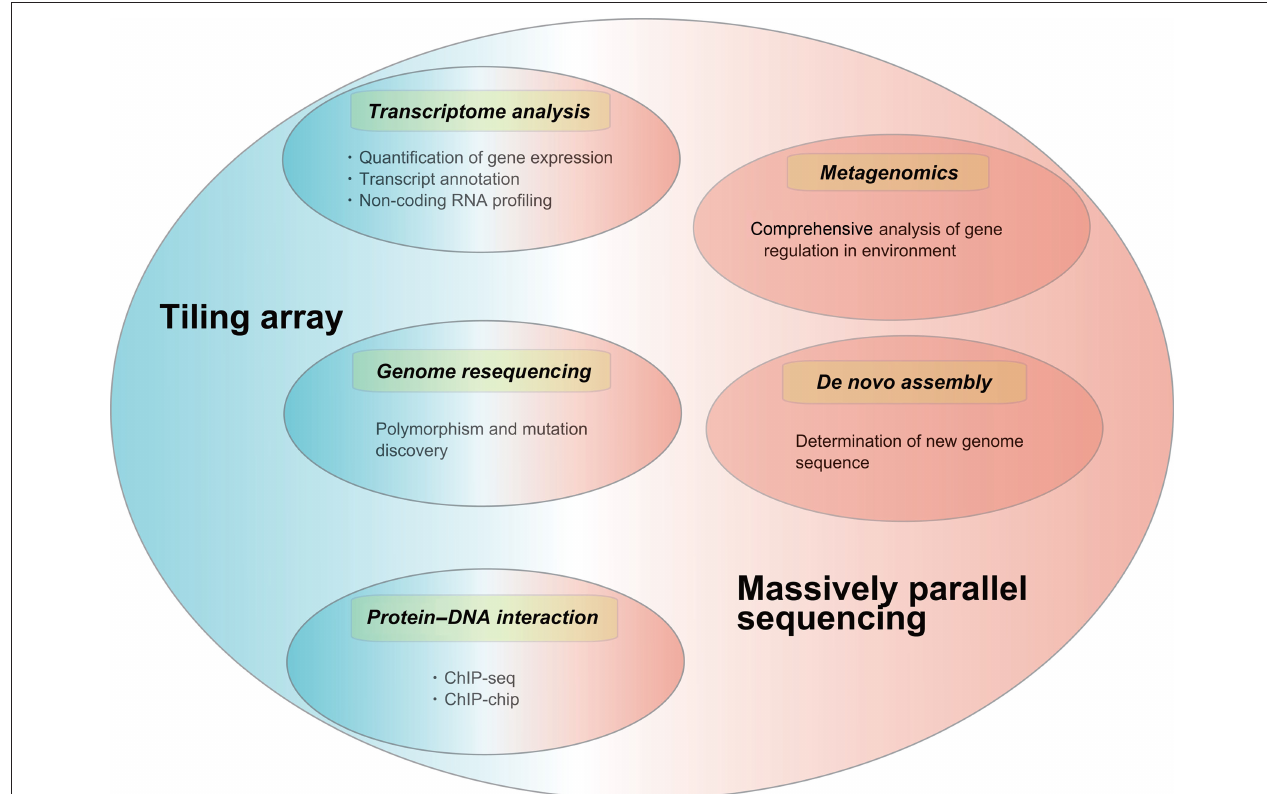
Figure 1 | Applications of tiling array and massively parallel sequencing. Transcriptome analysis, genome resequencing and protein–DNA interaction (ChIP-) studies can employ both tiling array and massively parallel sequencing while applications like metagenomic studies and de novo assembly can only be performed using massively parallel sequencing. Tiling array: Blue, Massively parallel sequencing: